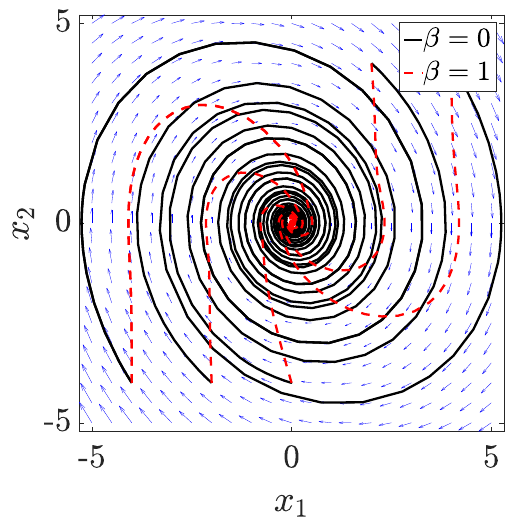
Figure 1. Van der Pol dynamics stabilized by proposed method.